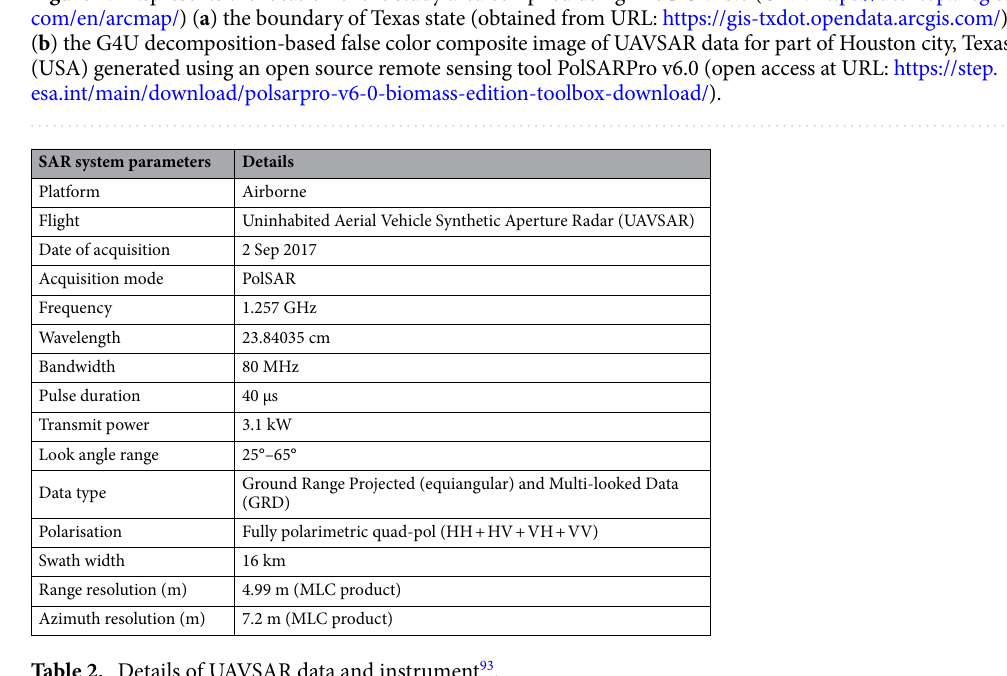
Table 2. Details of UAVSAR data and instrument 93